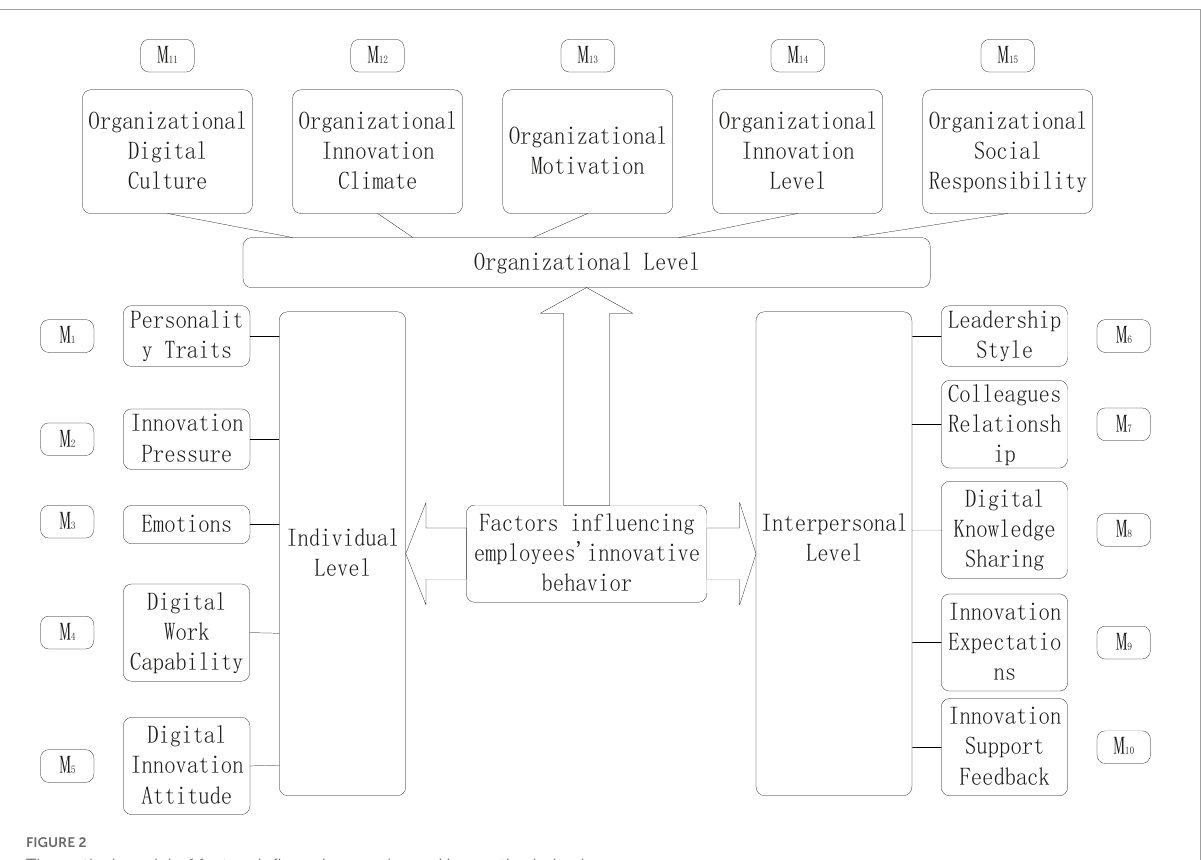
FIGURE2 Theoretical model of factors influencing employees’ innovative behavior.